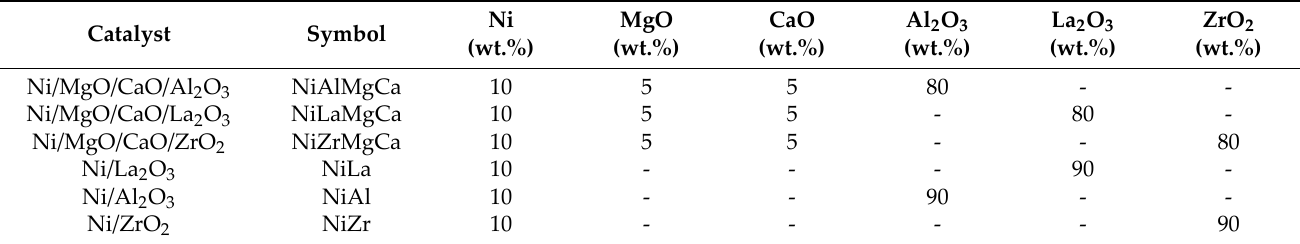
Table 4. The weight percentage of each catalyst